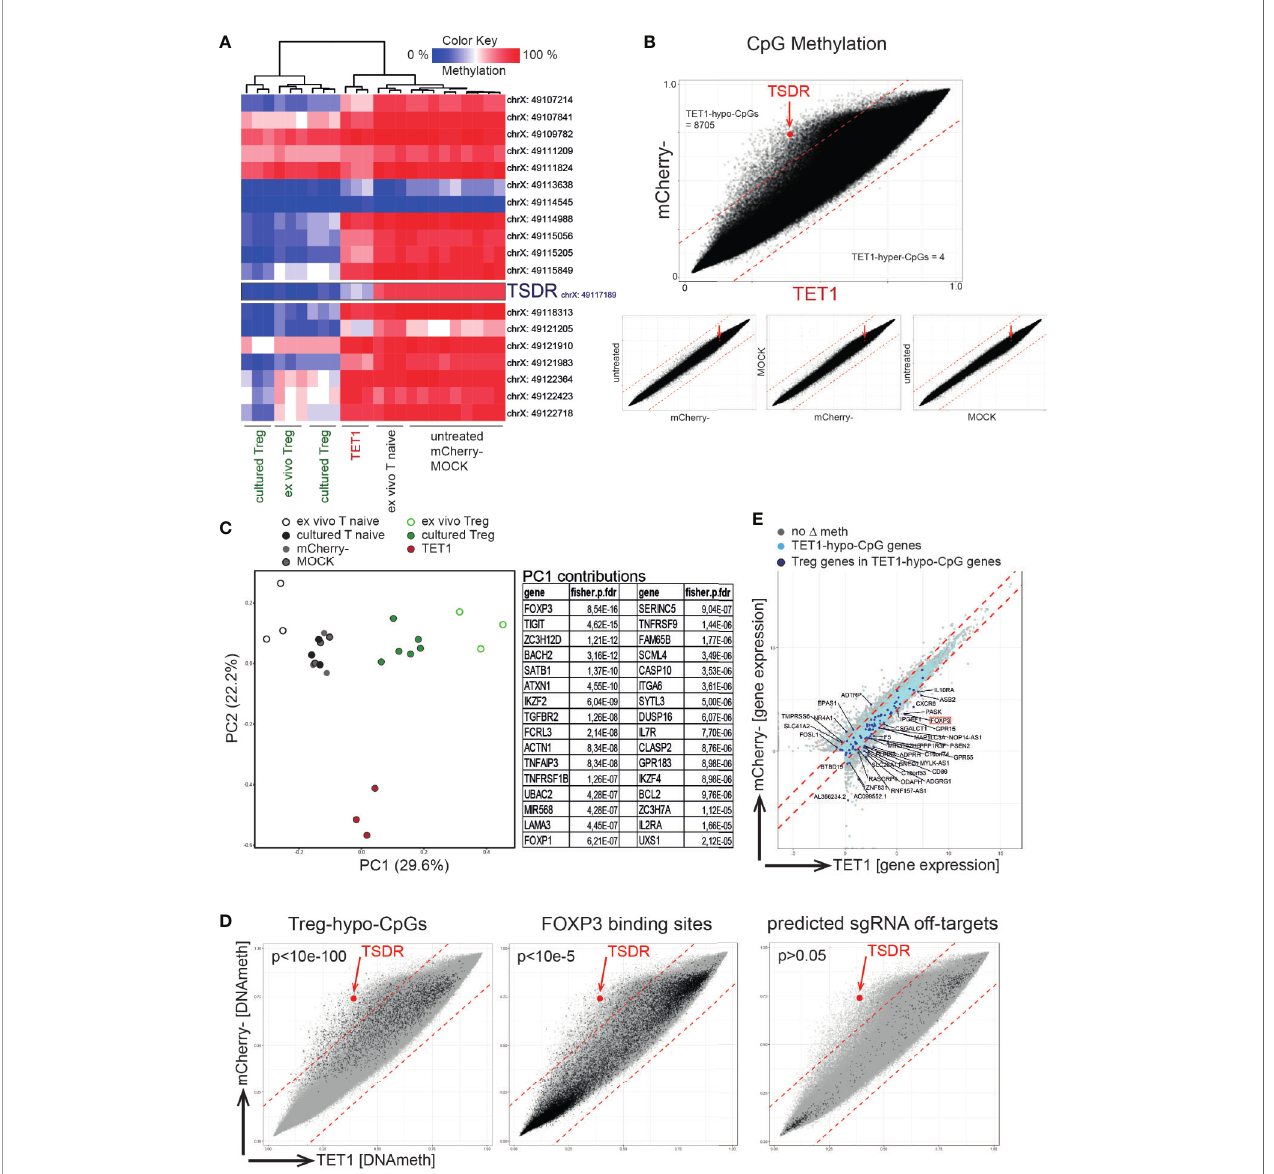
FIGURE 2 | Targeted TSDR de-methylation results in a partial remodeling of the DNA methylome towards a Treg signature. Successfully transfected mCherry+ naïve T cells ( “ TET1 ” ) on day 7 post transfection were analyzed for their genome-wide DNA methylation pro fi le using the 850K Illumina EPIC bead-chip Array and compared to ex vivo isolated and cultured Treg (positive controls) as well as to several negative controls [ex vivo naïve T cells ( “ Tnaive ” ), untreated cultured Tnaive, MOCK treated and mCherry- cells]. (A) Hierarchical clustering of analyzed samples (n = 3) based on the methylation degree of all CpGs within the FOXP3 locus (genomic locations indicated). The TSDR is highlighted. (B) Correlation plots of all EPIC Array CpGs for the indicated samples (mean of n = 3). The TSDR is highlighted (red dot and arrow), the numbers of TET1-hypo- and TET1-hyper-methylated CpGs are indicated. (C) left: PCA of EPIC Array DNA methylation data. right: The top 32 genes enriched with differentially methylated CpGs contributing to PC1 are listed (based on adjusted fdr values). (D) Correlation plot of TET1 vs. mCherry- samples (as in B) with highlighted selections of CpGs. left: Treg-hypo-CpGs (cultured Treg vs. cultured untreated naïve T cells, D ≥ 0.2), middle: FOXP3 binding sites (46), right: predicted off-targets of the 12 sgRNAs. p-values for enrichments within TET1-hypo-CpGs are indicated ( fi sher exact test). (E) Correlation plot of gene expression values (from RNAseq) in TET1 vs mCherry- samples. Genes enriched with TET1-hypo-CpGs are indicated in light blue or in dark blue in case they are also differentially expressed in Treg vs. Tnaive ( “ Treg genes ” ). The names of the Treg genes which are enriched with TET1-hypo-CpGs and displaying differential expression in TET1 samples are